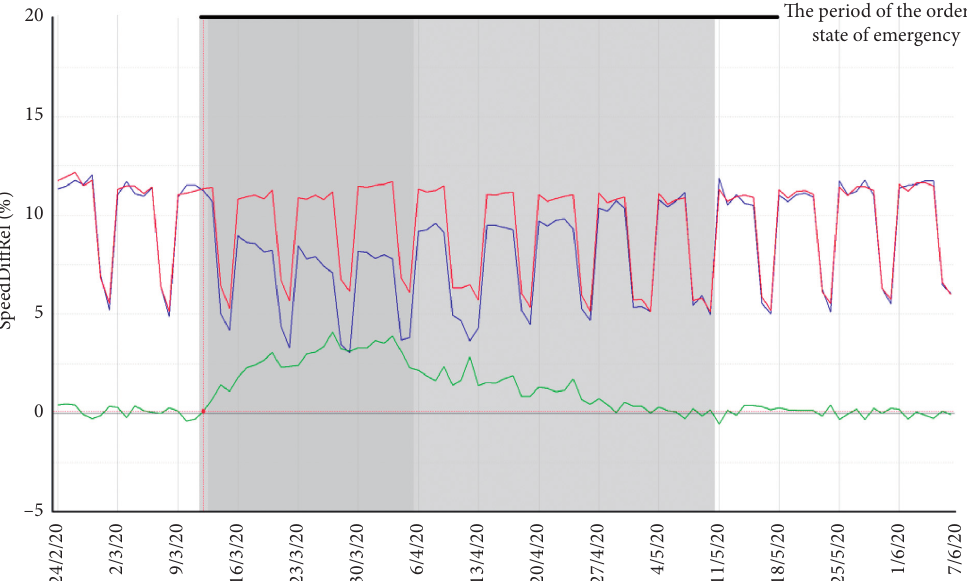
Figure 8: Deviation of the measured and predicted speed values from FreeFlowSpeed for 1 st class roads in the period from 24 February to 7 June 2020. These are the daily average